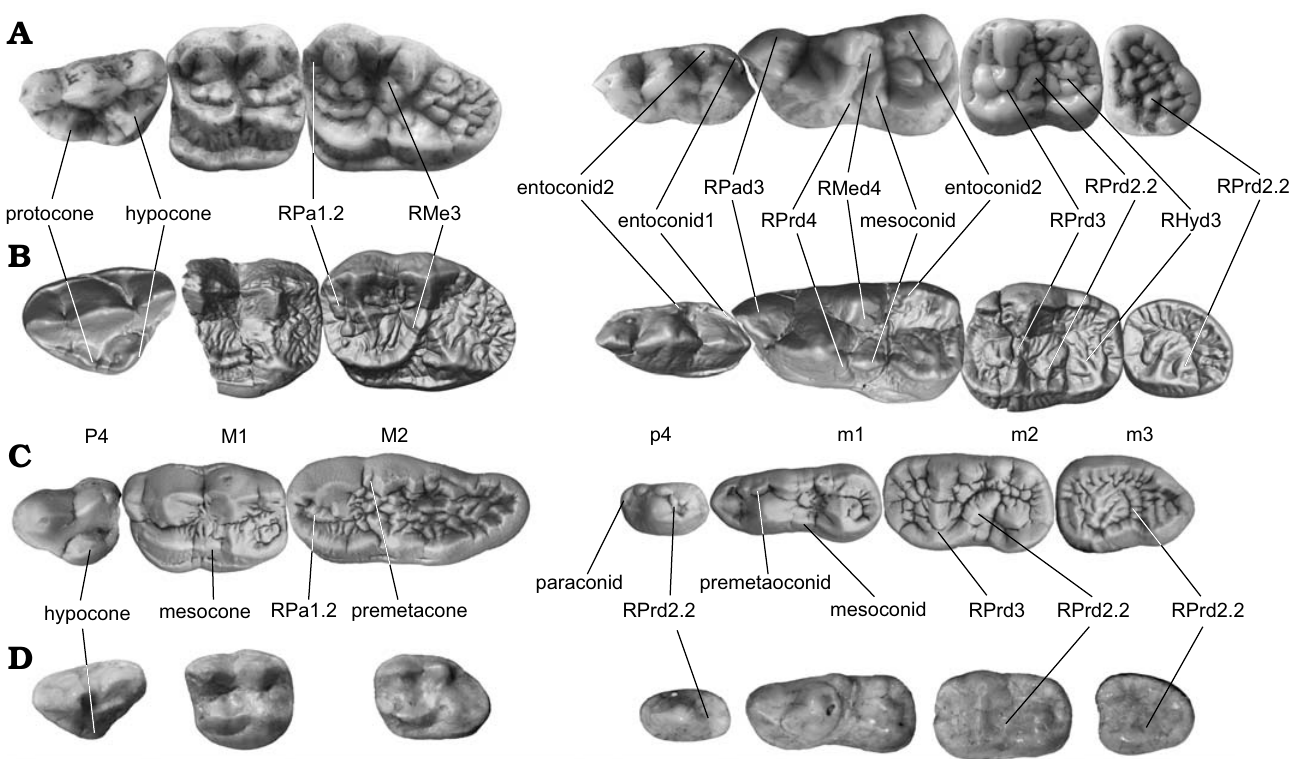
Fig. 1. Occlusal views of cheek teeth of studied bears. A . Ailuropoda sp. from Pleistocene of China. B . Ailurarctos lufengensis Qiu and Qi, 1989 (m1, IVPP V25032 and others IVPP V6892, reconstructed from CT scanning) from Lufeng, Yunnan Province, Latest Miocene. C . Ursus deningeri von Reichenau, 1904 (NMM1946/643, 1953/119, 1953/119, 1955/818, 1956/907, 1953/54, 1956/909; photo Jan Wagner) from Mosbach 2 locality, Germany, early Middle Pleistocene. D . Ursavus tedfordi Qiu, Deng, and Wang, 2014 (HMV1453) from Huaigou, Gansu Province, Late Miocene. For terminology and more details for dental character see Fig. 2. Not to scale. Abbreviations: RHyd3, medial ridge of protoconid; RMe3, medial ridge of metacone; RMed4, postero-medial ridge of metaconid; RPa1.2, medial branch of anterior ridge of paracone; RPad3, medial ridge of paraconid; RPrd2.2, medial branch of the posterior ridge of protoconid; RPrd3, postero-medial ridge of protoconid; RPrd4, postero-lateral ridge of